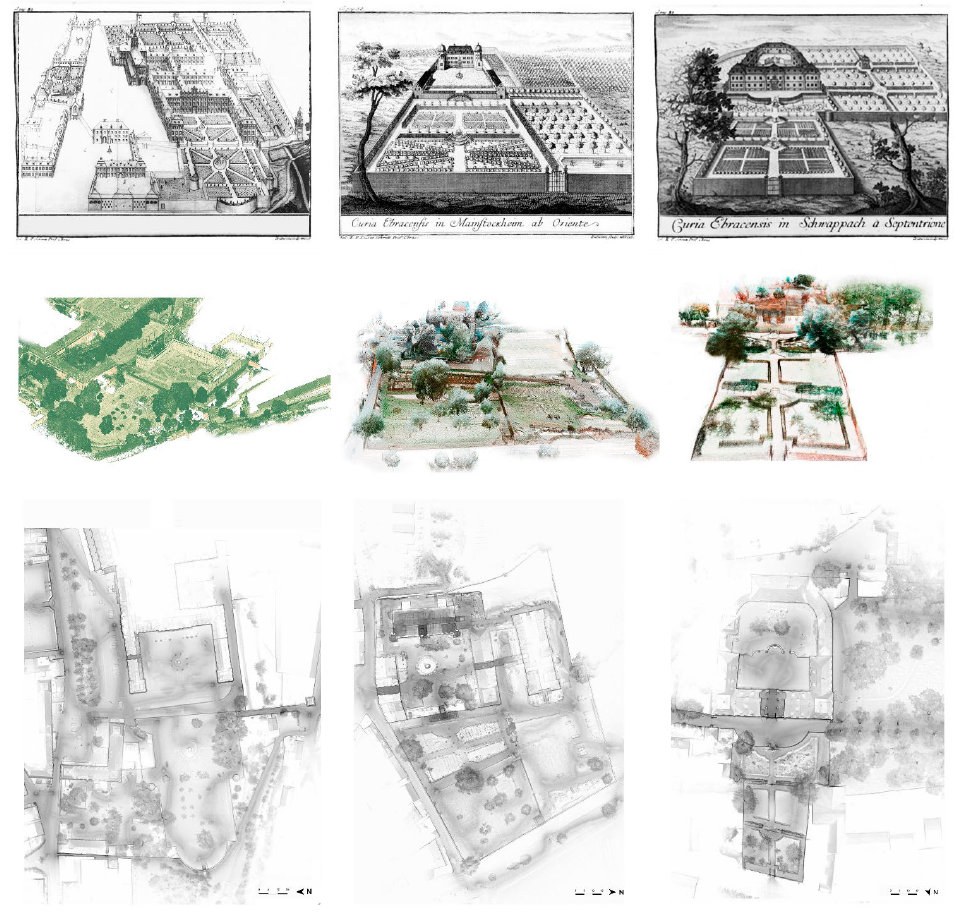
Figure 5: Matrix of comparison of historic incisions (top) with their 3D SLAM-based recordings shown as coloured 3D point cloud (middle) and greyscale planview (bottom). Monastery of Ebrach (left), Curiae Ebracensis Mainstockheim (middle), Curiae Ebracensis Oberschwappach (right). The historic incisions at the top are from 1803 for Monastery Ebrach by N.A. Berwein (Wiemer, 1999, p. 180), Mainstockheim and Oberschwappach both from 1738 (B.Gutwein after L.Schmidt in Brevis Notitia). The bottom left image of the point cloud of the monastery of Ebrach only shows part of the complete pointcloud that was recorded to facilitate a visual comparison of the main gardens. The main facades’ widths are ca. 65-70